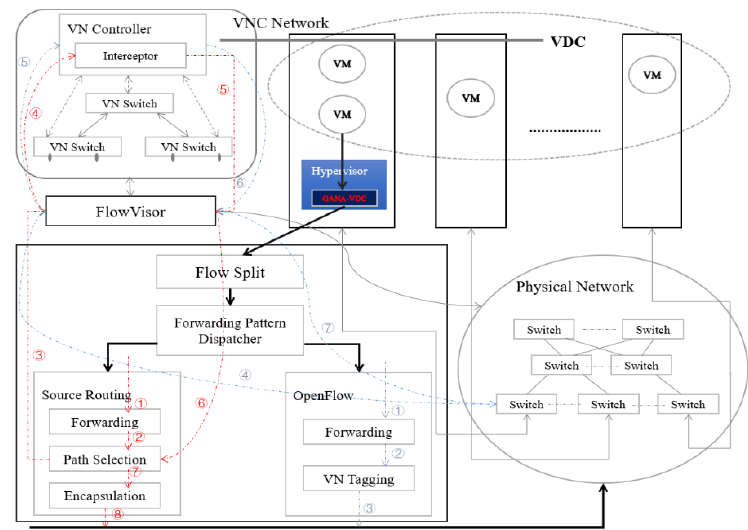
Figure 4. GANA-VDC system architecture.